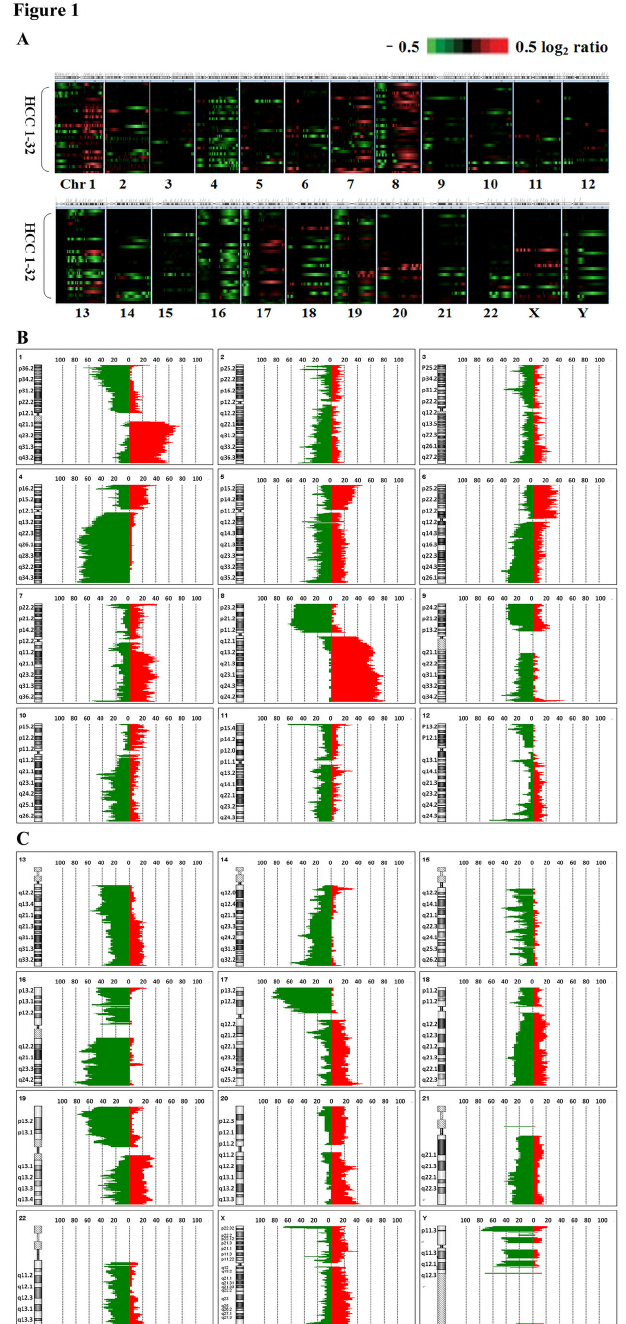
Figure 1. Whole-genome profiles and frequency plots of chromosomal alterations in HCC patients (z-scoring:2.5). (A) The genomic alterations in tumor samples from each HCC patient (n = 32) are illustrated in individual vertical lanes. A total of 573 gene copy number alterations were mapped and ordered by chromosomal position from 1pter to Yqter using the workbench Lite Edition 6.5.0.18. Tumor versus the reference intensity ratios (in log ratio) for individual tumor samples are plotted in different color scales 2 reflecting the extent of increases (red) or decreases (green) in copy number. The detail chromosomal alterations were shown in 1B (chromosome 1 to chromosome 12) and in 1C (chromosome 13 to chromosome 22, X chromosome and Y chromosome, respectively). Nine chromosomes showed increased chromosomal DNA (1q, 5p, 6p,7q, 8q, 17q, 20p, 20q and X) and 16 chromosomes had deceased chromosomal DNA (1p, 4q, 8p, 9p, 10q,13q, 14q, 16p, 16q ,17p ,18q, 19p ,19q, 21q, 22q and Y) that were repeatedly observed in > 20% of tumor samples. doi: 10.1371/journal.pone.0083465.g001 PLOS ONE |